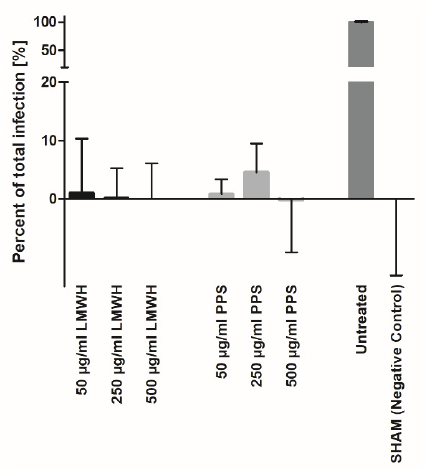
Figure 5. Concentration-dependent inhibition of SARS-CoV-2 cell infection of LMWH and PPS normalized to untreated positive control, as determined by RT-qPCR (SHAM: not infected, untreated cells = negative control) .